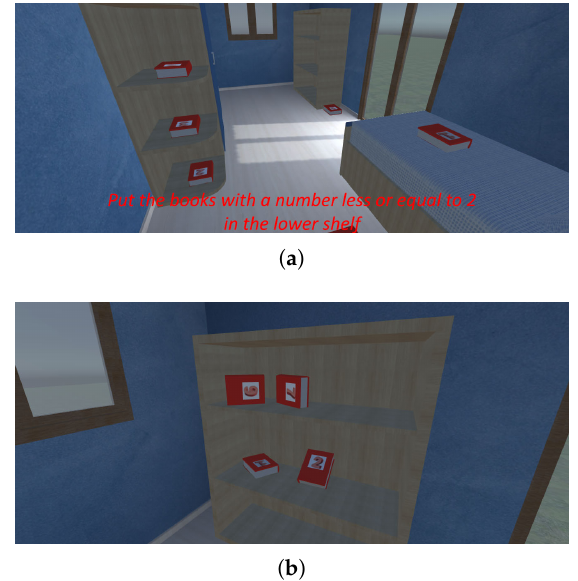
Figure 9. An example of the pivot number exercise. In Figure ( a ), the task is presented to the patient, while in ( b ) the completed exercise is